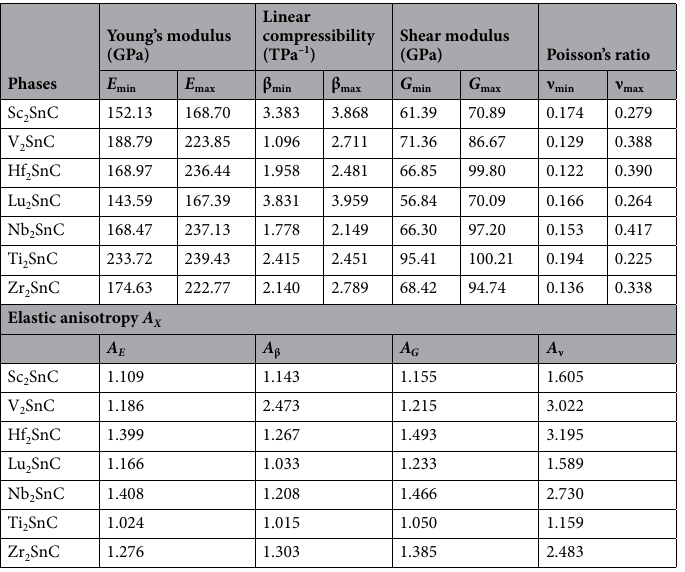
Table 1. Minimal and maximal values of each modulus and elastic anisotropy of Sc 2 SnC and existing M 2 SnC 16,17